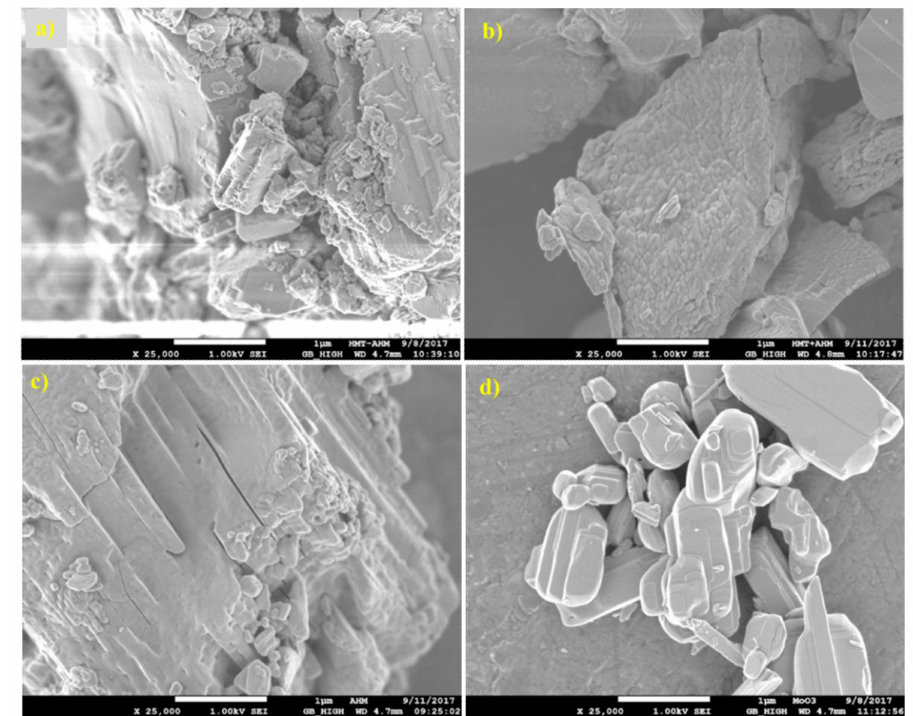
Figure 5. Scanning electron microscopic (SEM) micrographs of the synthesised precursors ( a ) HMT-AHM 7.5 × and ( b ) HMT-AHM-S (2:1), and the starting feedstock ( c ) AHM and ( d ) MoO 3 .